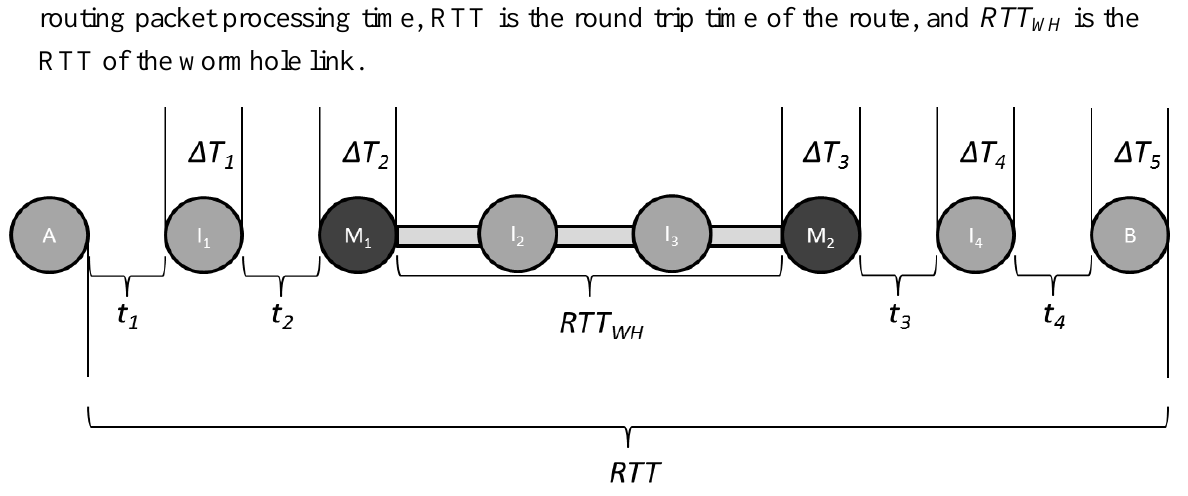
is 2 x PTT between two successive nodes, ∆T i